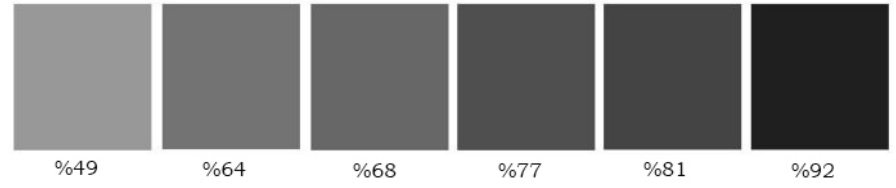
Figure 10. Based on a color palette and K percentages.